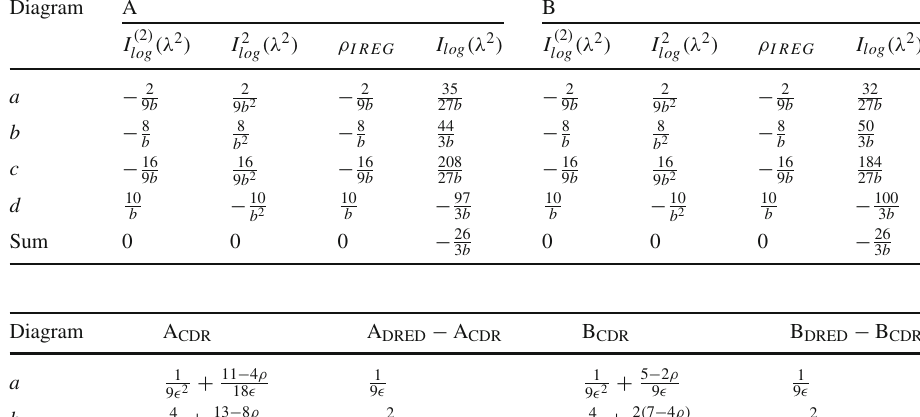
Table 16 Results for fermionic part of QCD using CDR and DRED